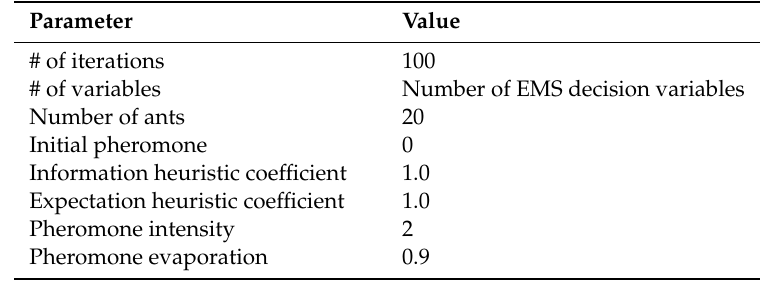
Figure 3. Flowchart of the ant colony optimization (ACO) algorithm. Table 1. Ant colony optimization (ACO) parameters. EMS: energy management system.